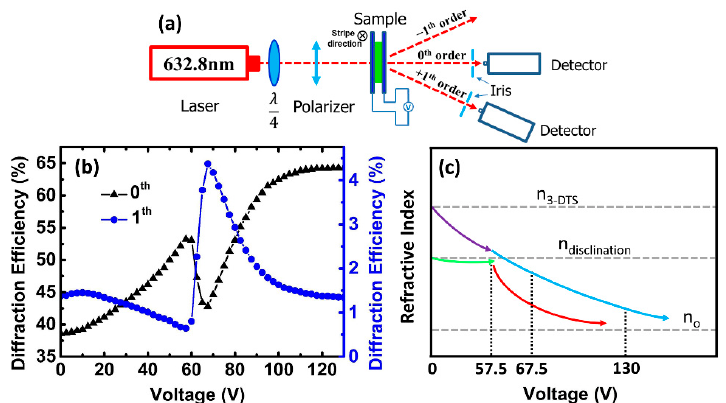
Figure 3. ( a ) Experiment setup for measuring the diffraction efficiency of the PS-SPLC grating. ( b ) Voltage dependent diffraction efficiencies of the zeroth and first orders. ( c ) Schematic diagram of the refractive index mismatch between the 3D twist spheres (3-DTSs) ( n 3-DTS ) and the disclinations ( n disclination ). index mismatch between the 3D twist spheres (3-DTSs) ( n 3- DTS ) and the disclinations ( n disclination